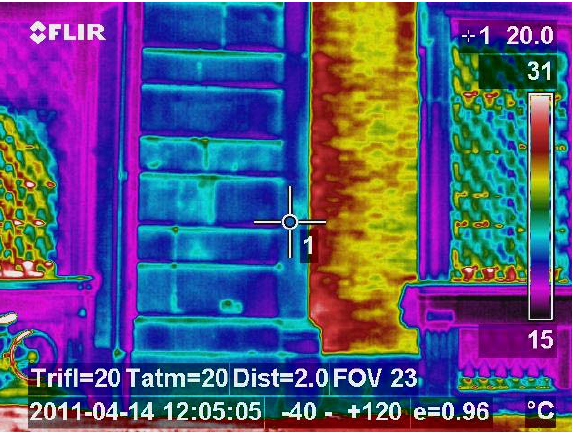
Figure 13. Façade of Royal Palace in Caserta